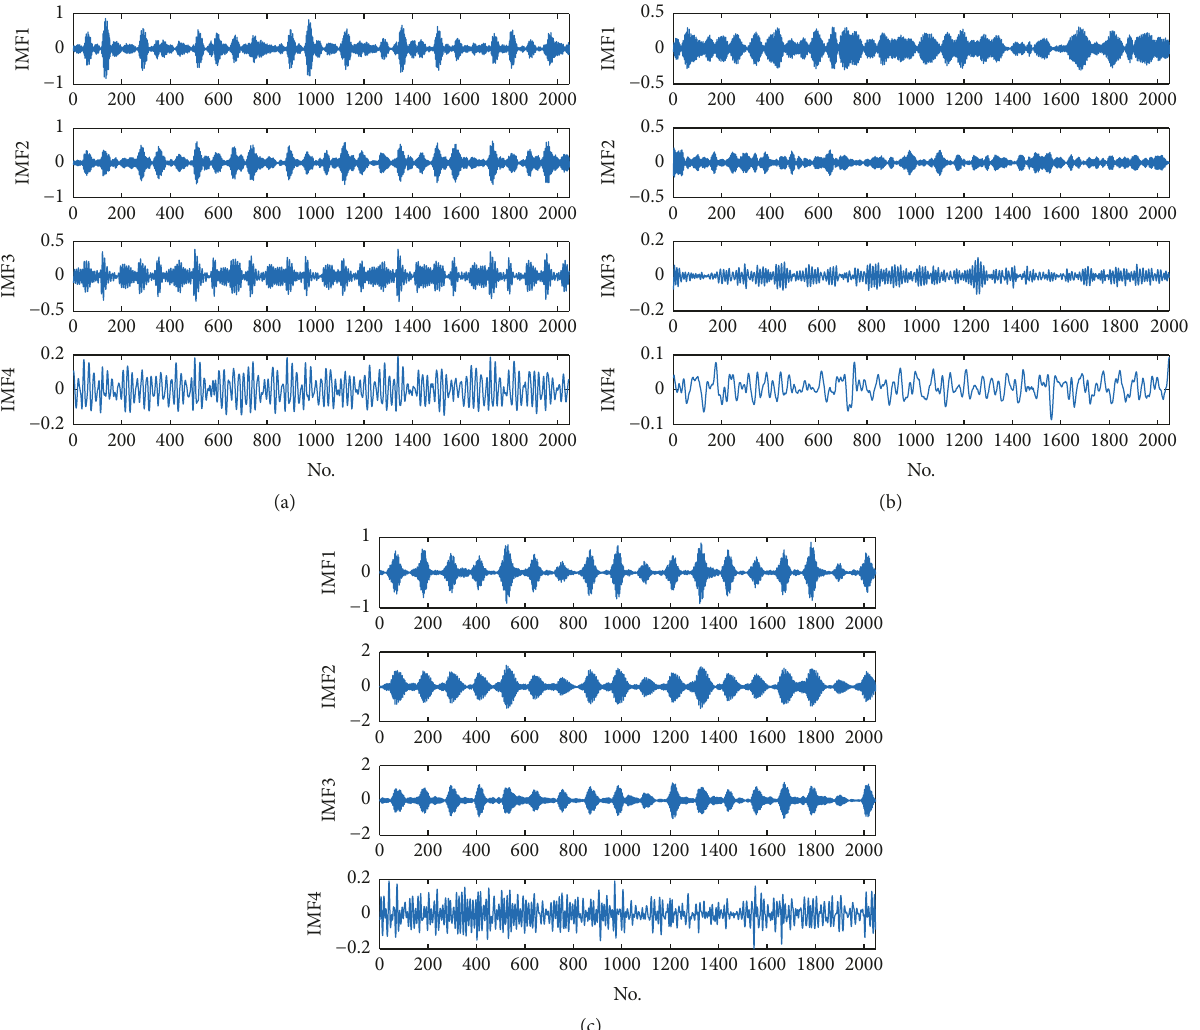
Figure 4: The VMD decomposition results of 0.007 inches fault signals: (a) inner race, (b) ball, (c) outer